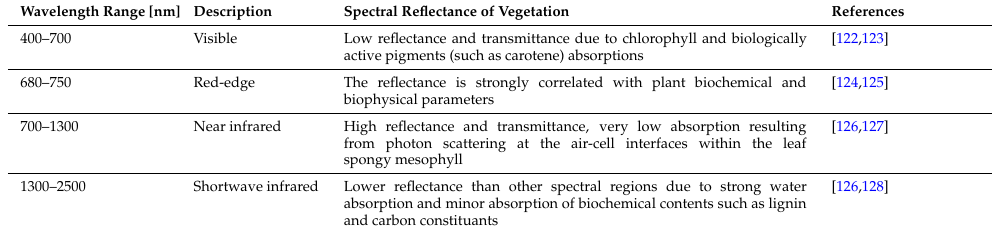
Table 6. The spectral reflectances of green vegetation on the four regions of electromagnetic spectrum from